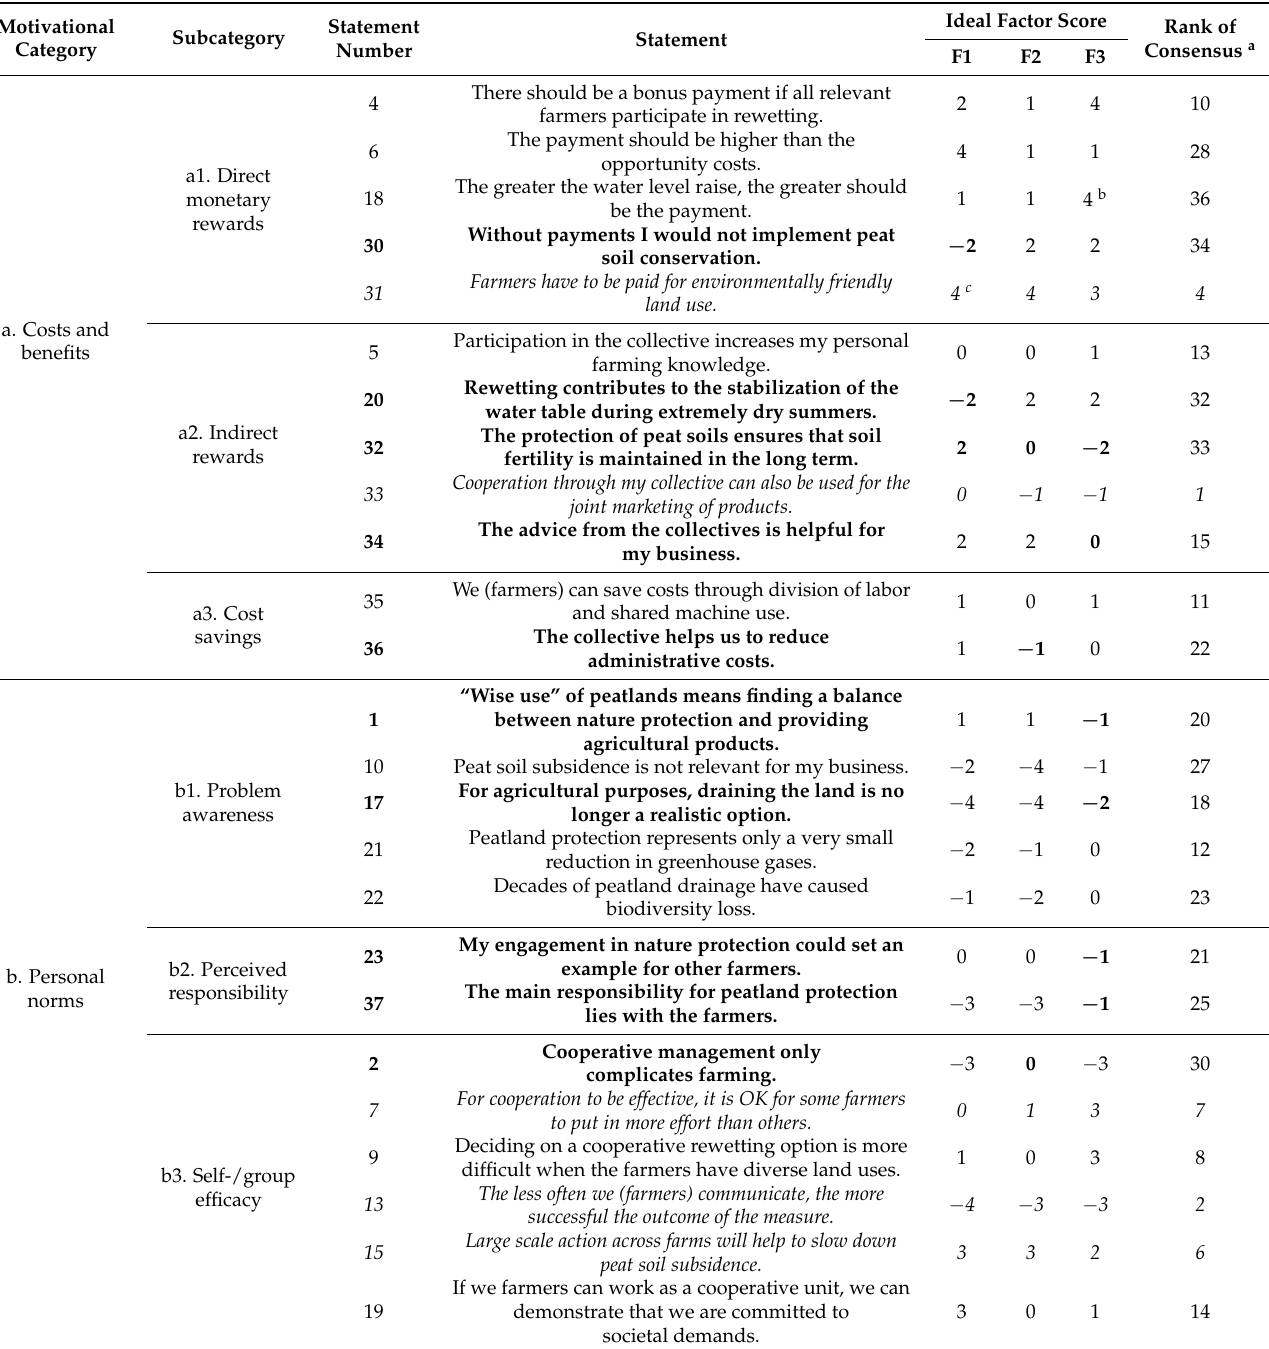
Table 2. Factor scores and z-scores per statement, sorted by motivational